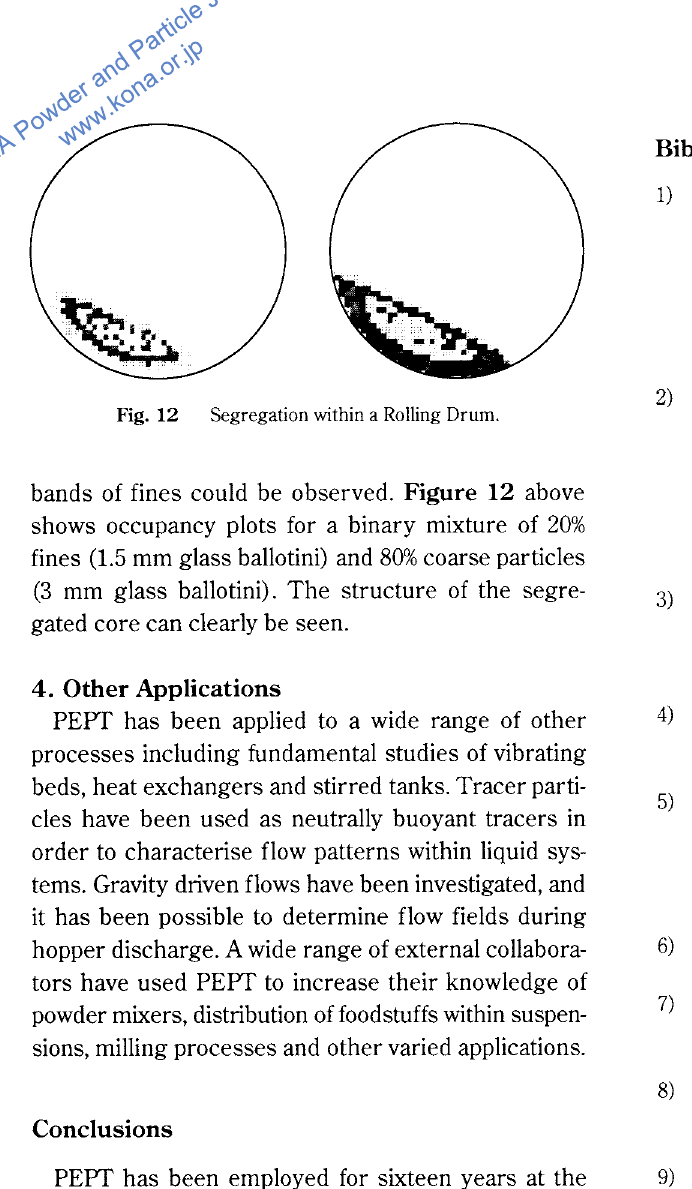
Fig. 12 Segregation within a Rolling